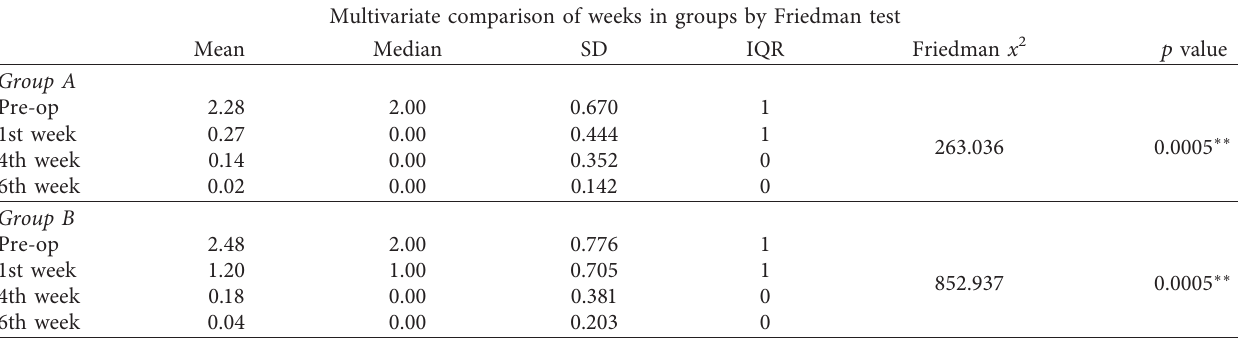
Table 6: Multivariate analysis in group A and group